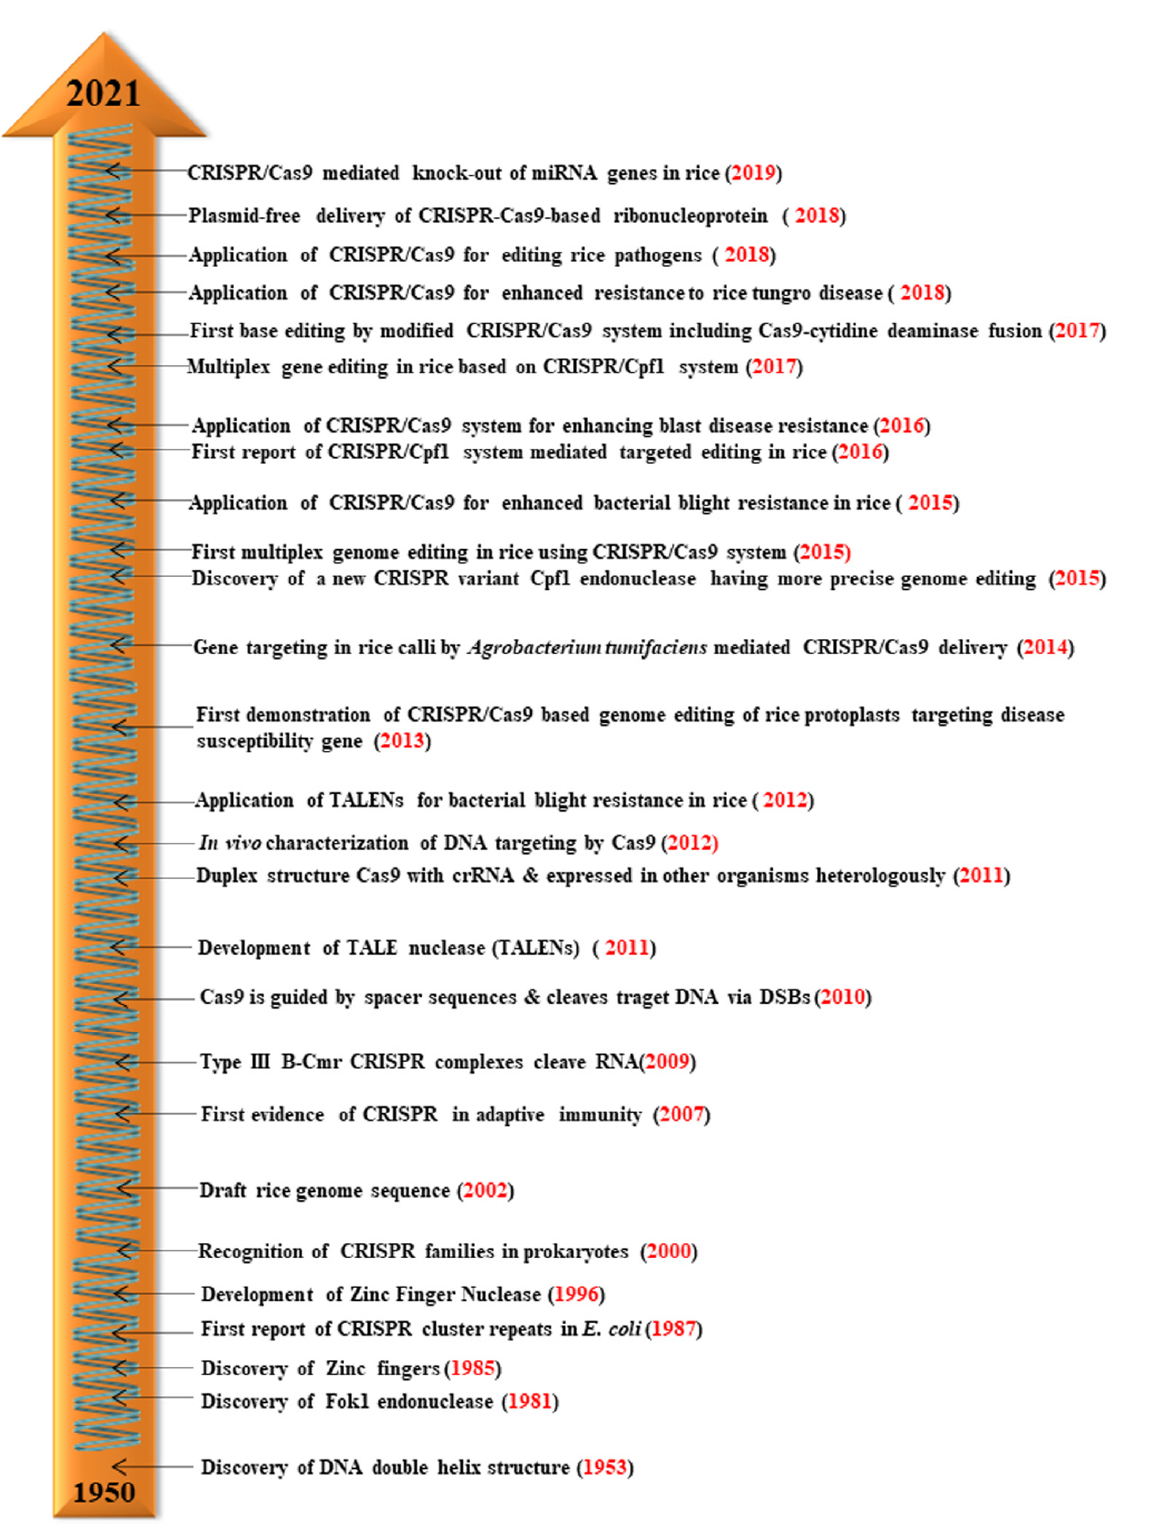
Figure 2. Timeline of key developments of genome editing technology in rice for enhanced disease resistance. All the entries are based on the data mining with eight keywords (rice, HR, NHEJ, CRISPR/Cas9, biotic stress, pathogens, genes, and editing) in PubMed (https://pubmed.ncbi.nlm.nih.gov/) (Accessed on 22 December 2021) and Google scholar (https://scholar.google.co.in/) (Accessed on 9 January 2022).